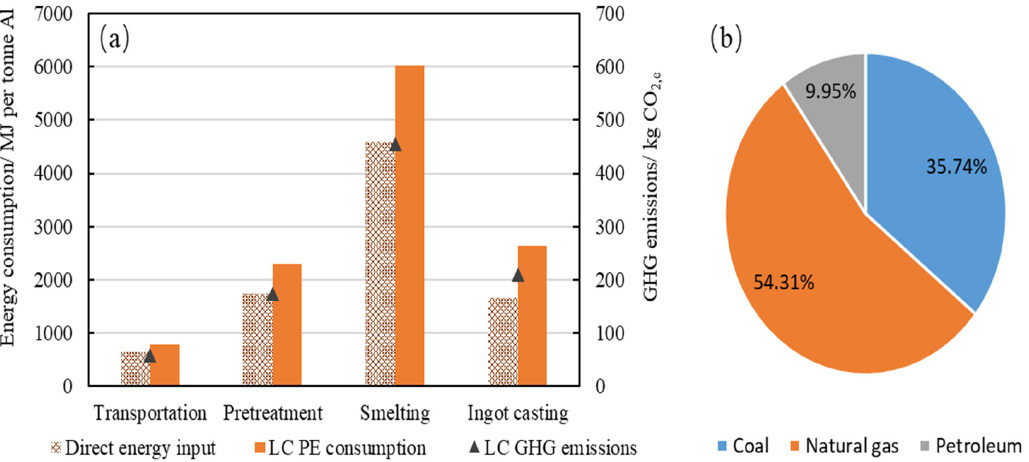
Figure 3. LC results of recycled aluminum in mainland China in 2020 (a); and the proportion of each primary fossil energy (b).